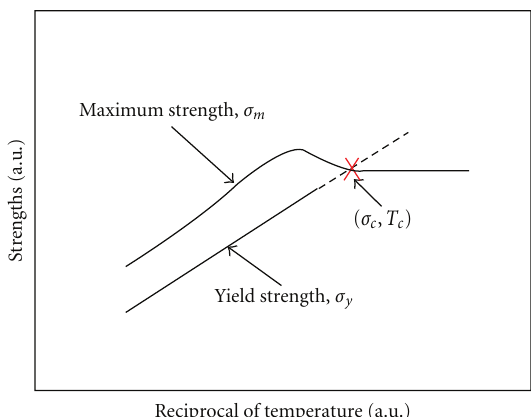
Figure 1: Definition of critical stress and critical